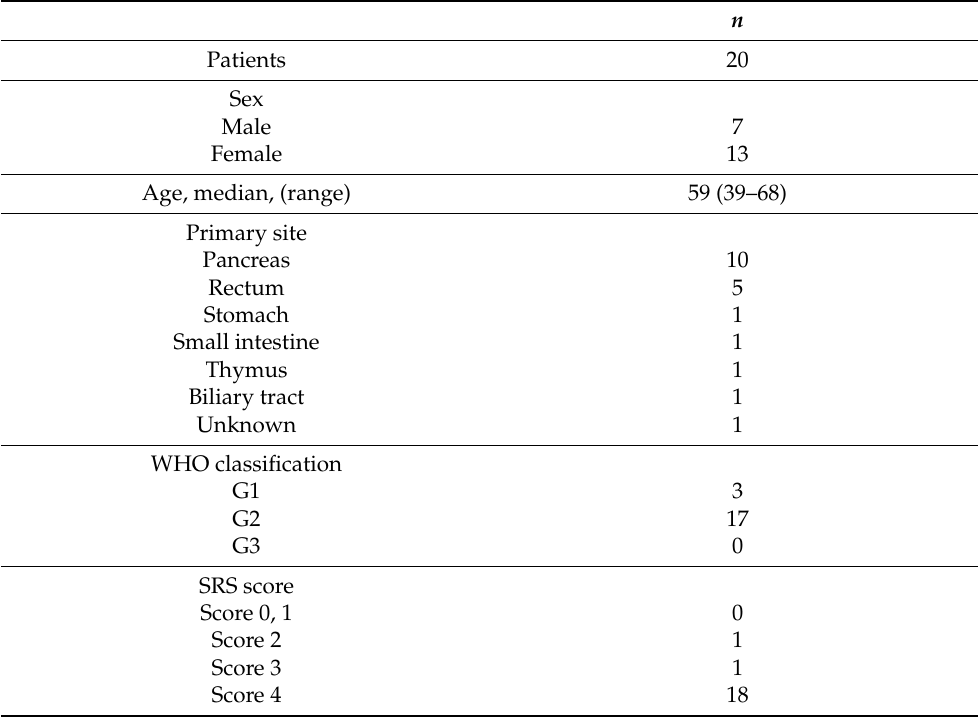
Table 1. Patient